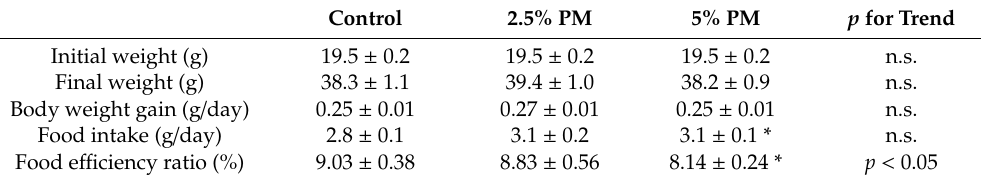
Figure 1. Increase in blood glucose levels in the oral glucose tolerance test (OGTT). Error bars represent standard error ( n = 10). Paramylon (PM) displayed significant dose-dependent effects in reducing the blood glucose increase level at 60 min ( p < 0.05). * The increase in blood glucose at 60 min was significantly reduced in the 5% PM group compared with the control group ( p < 0.05). Table 3. Body weight gain, food intake, and food efficiency ratio.